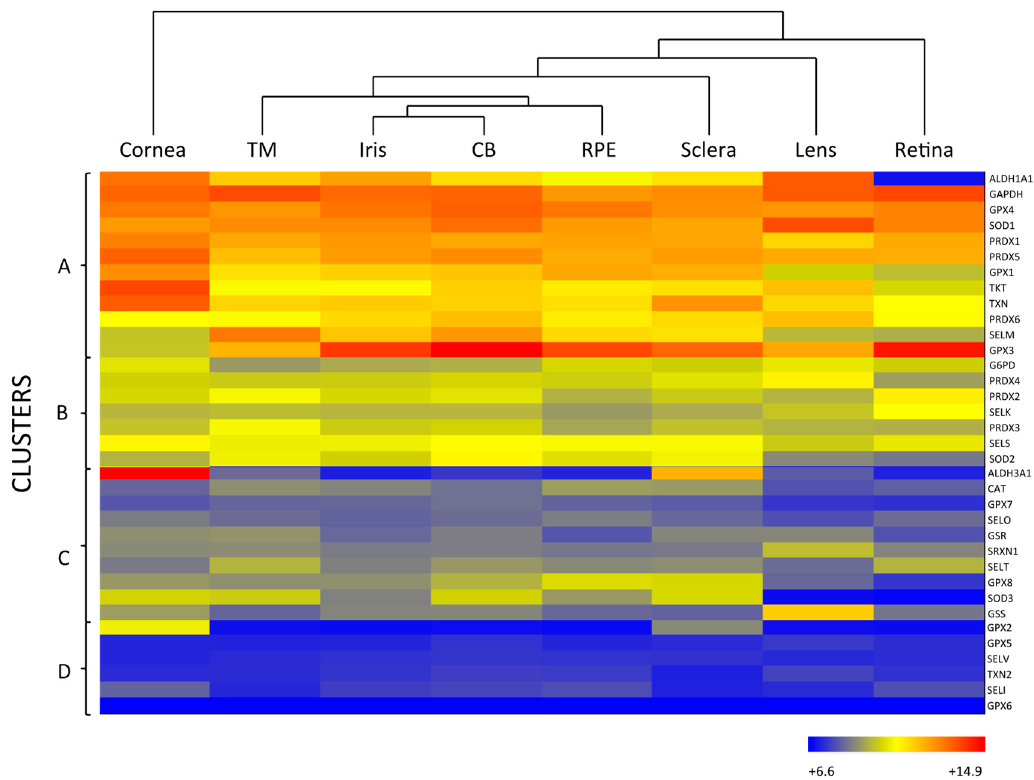
Figure 2. Hierarchical cluster and heat map (whole-genome expression microarrays) of the main antioxidant enzymes in human ocular tissues. The row at the top shows the clustering information in the form of a dendogram and the similarity relationships among the genes and tissues: cornea (n = 11), trabecular meshwork (TM; n = 9), CB (n = 12), sclera (n = 7), iris (11), RPE (n = 8), retina (n = 12) and lens (n = 10). The column at the left of the heat map shows four clusters (A to D), each with antioxidant enzymes expressed at different abundance. Mean values of 6.6–14.9 from biological replicas per tissue are indicated according to the log2 scale, in arbitrary units, depicted at the bottom. Hierarchical cluster and heat maps were created using Illumina BeadChip array platform (HumanHT-12 v4.0 Expression BeadChip Kit, Illumina, San Diego, CA, USA) and ArrayStar software, version 4 (DNASTAR, Inc, Madison, WI, USA) according to Alvarez et al., 2012 [15]. n: number of samples per tissue.